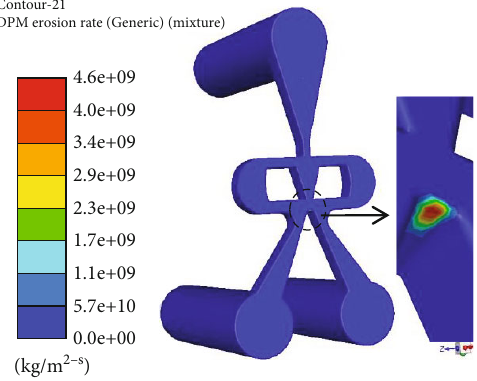
Figure 13: The diagram of erosion rate